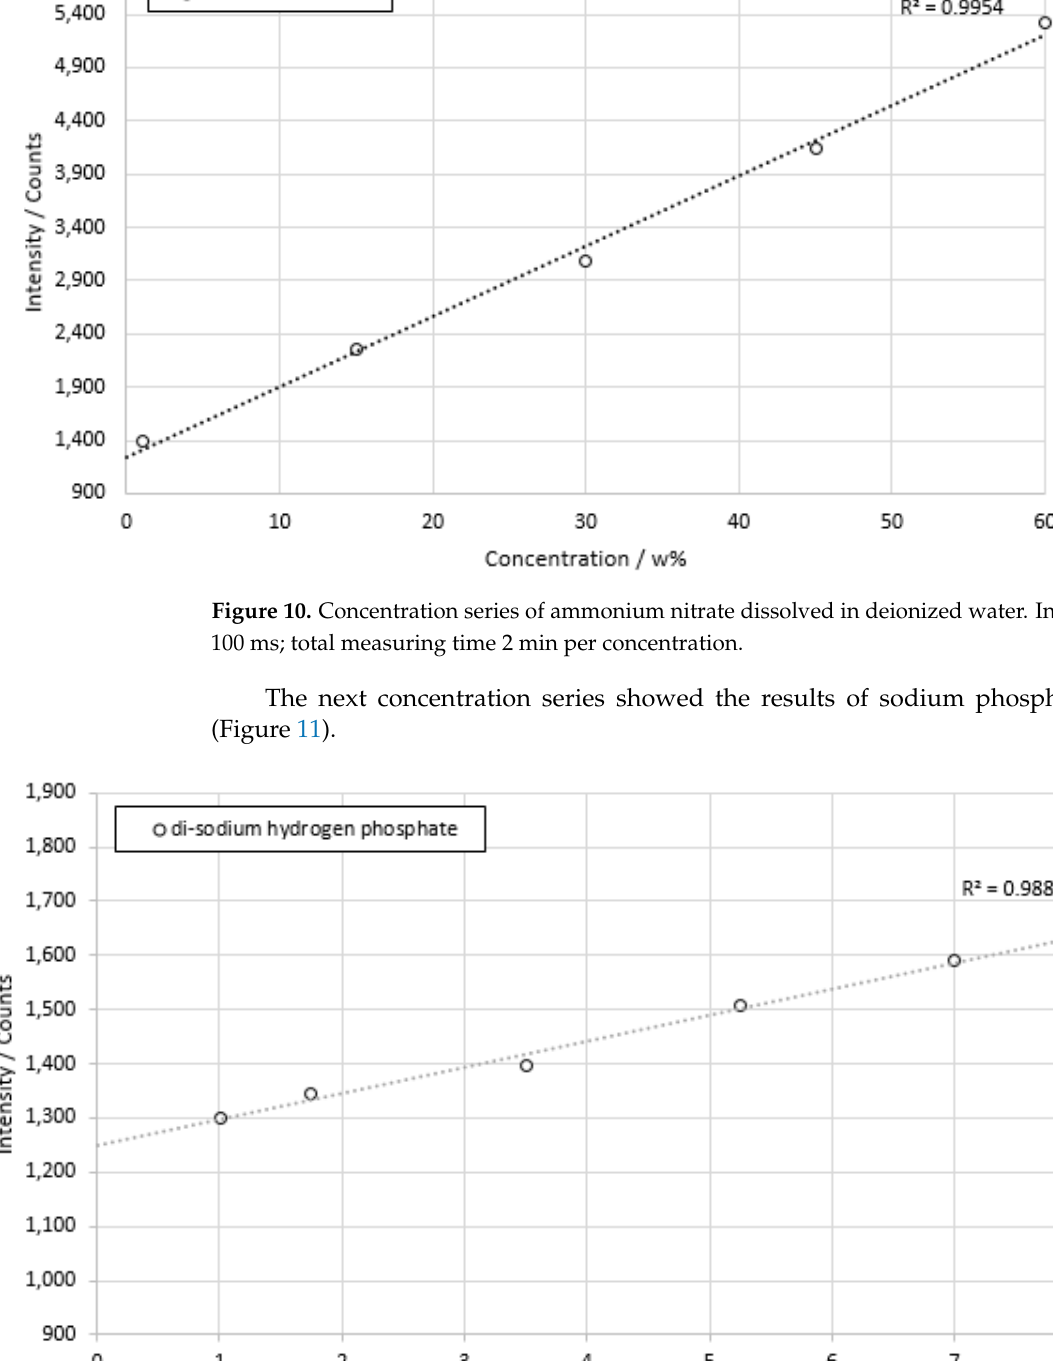
Figure 11. Concentration series of di-sodium hydrogen phosphate dissolved in deionized water. The integration time is 100 ms. Each concentration was measured for about a time of 2 min.